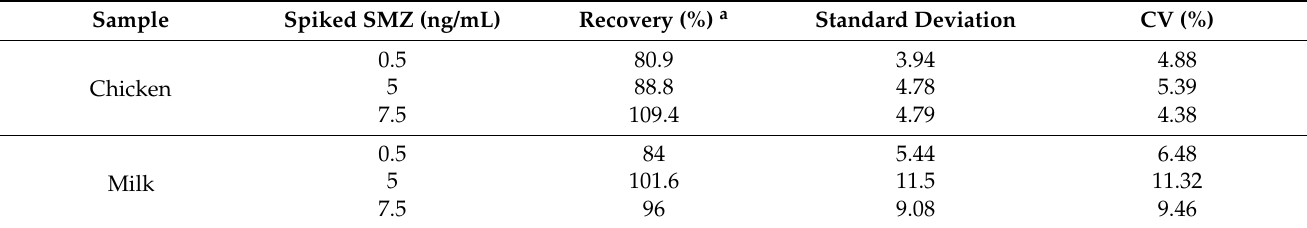
Table 2. Recoveries and CVs of chicken and milk samples spiked with different concentrations of SMZ with QBs–LFIA. Sample